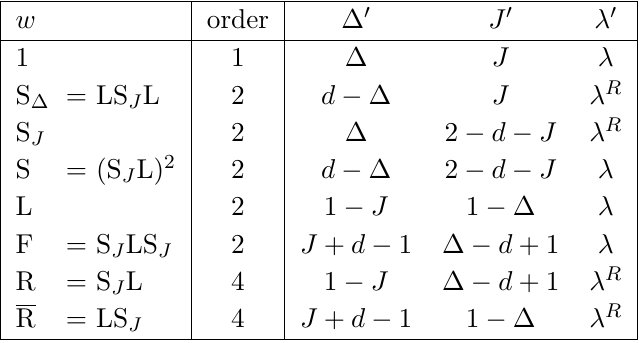
Table 1. The elements of the restricted Weyl group W 0 = D 8 of SO( d; 2). Each element w takes the weights ((cid:1) ; J; (cid:21) ) to ((cid:1) 0 ; J 0 ; (cid:21) 0 ). The order 2 elements other than S are the four re(cid:13)ection symmetries of the rectangle, while S is the rotation by (cid:25) . The center of the group is Z D 8 = f 1 ; S g . Finally, the element R is a (cid:25)= 2 rotation. The group is generated by L and S J , with the relations L 2 = S 2 = (LS J ) 4 = J